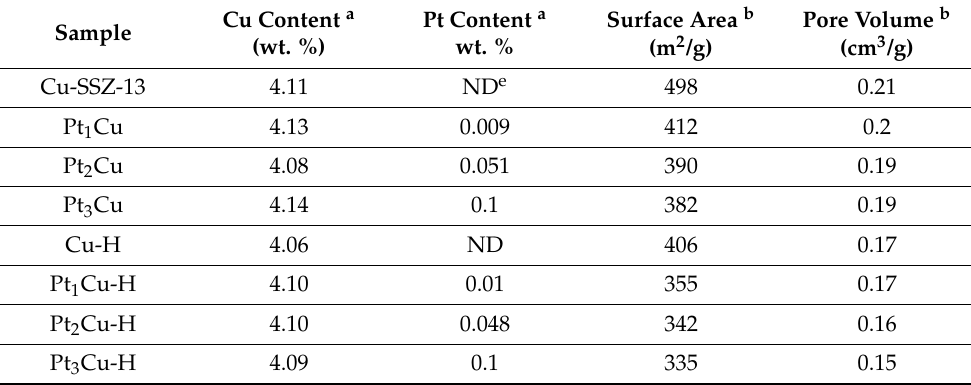
Table 2. The element content and textural properties of the